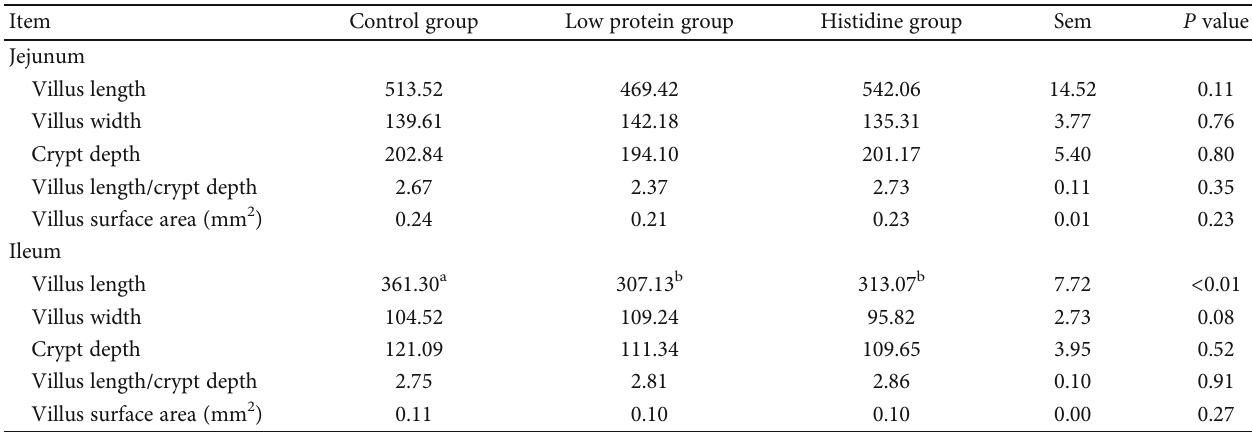
Table 5: E ff ect of dietary histidine on intestinal morphology in low protein diet-fed